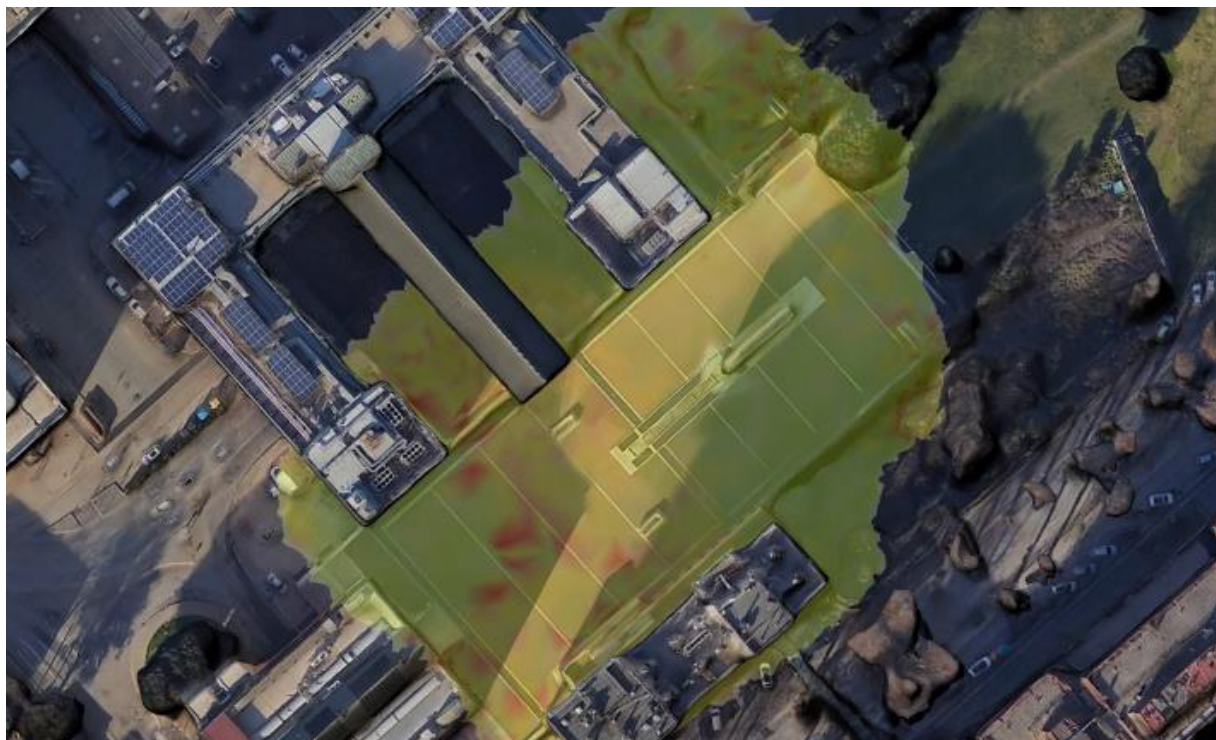
Figure 9- DEM in planimetric view with the addition of color attributes according to the EEG data related to the circumplex model.